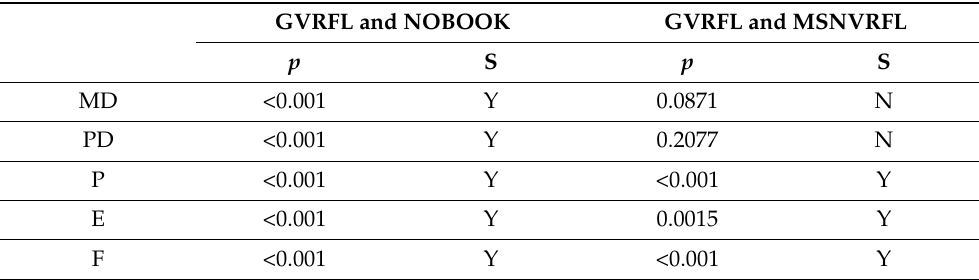
Table 4. Single factor analysis of NASA user evaluation. GVRFL and